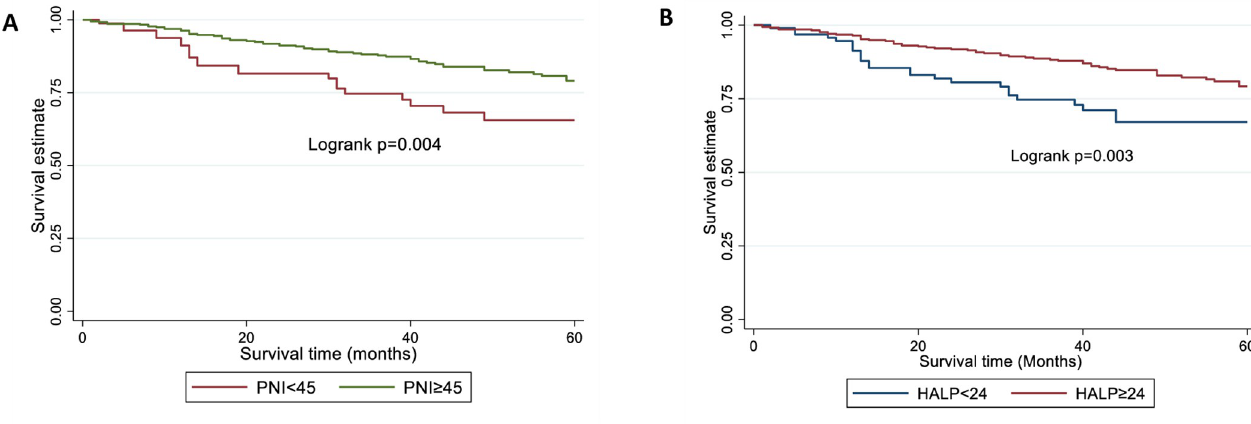
Fig 1. Kaplan-Meier survival curves showing overall survival estimates by prognostic categories in women with endometrial cancer. (A) PNI (B) HALP. There was no evidence for an effect of pre-treatment PNI on recurrence free survival.